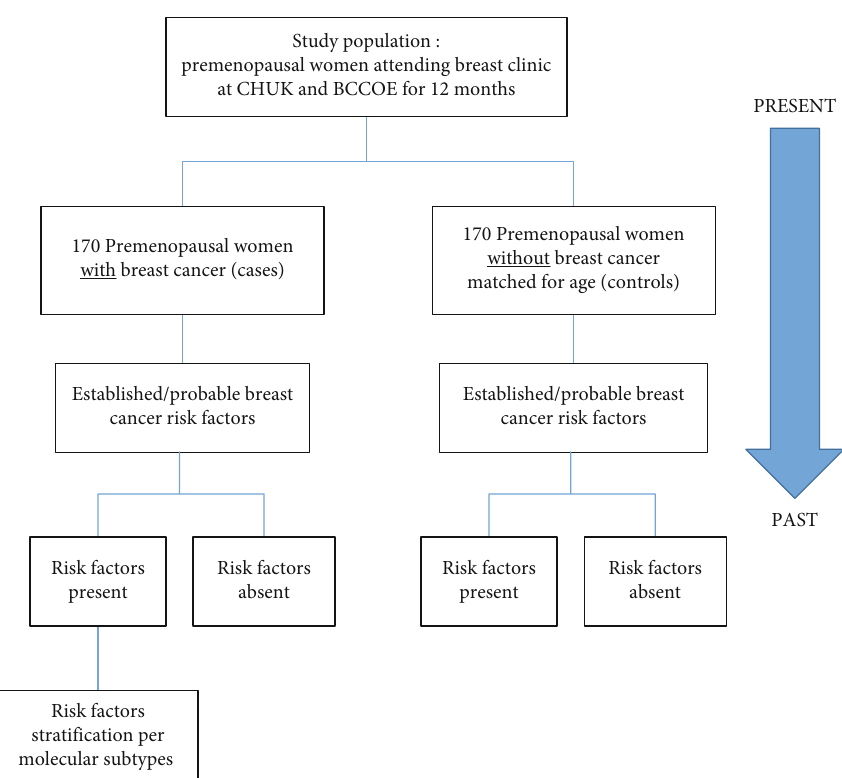
Figure 1: Methodology